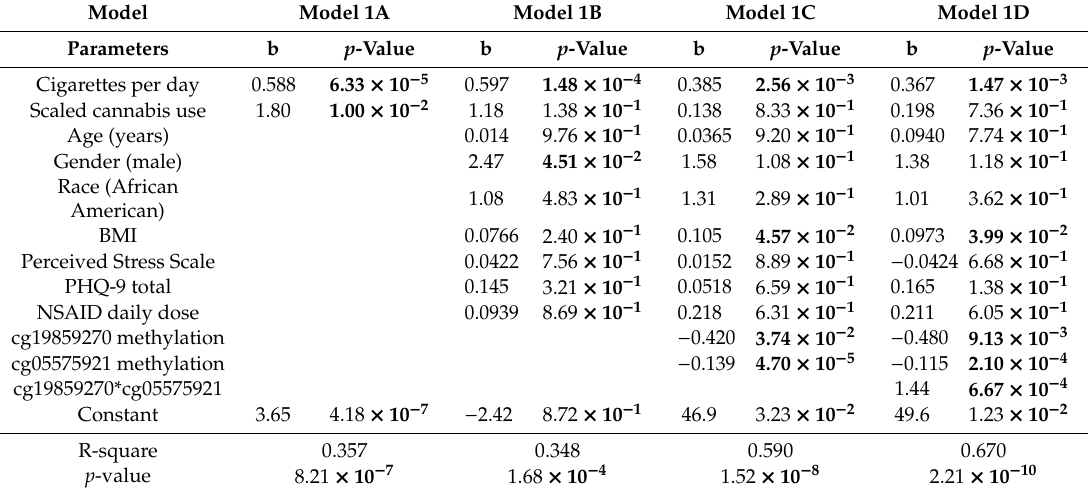
Table 2. Multiple linear regression results for GPR15 + Th cell percent regressed against tobacco and cannabis smoking